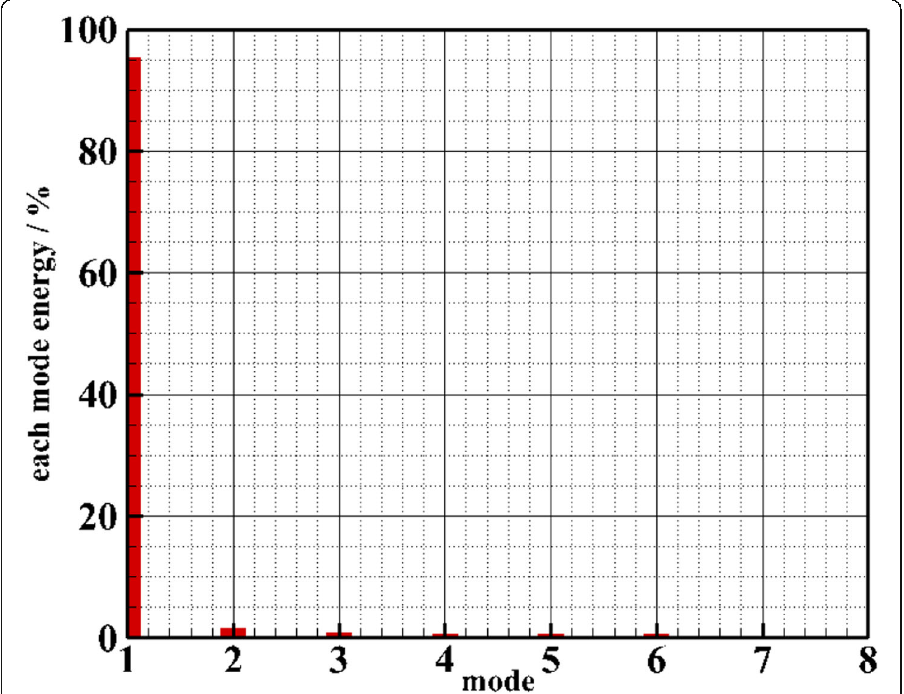
Fig. 21 Energy distributions of the first eight POD